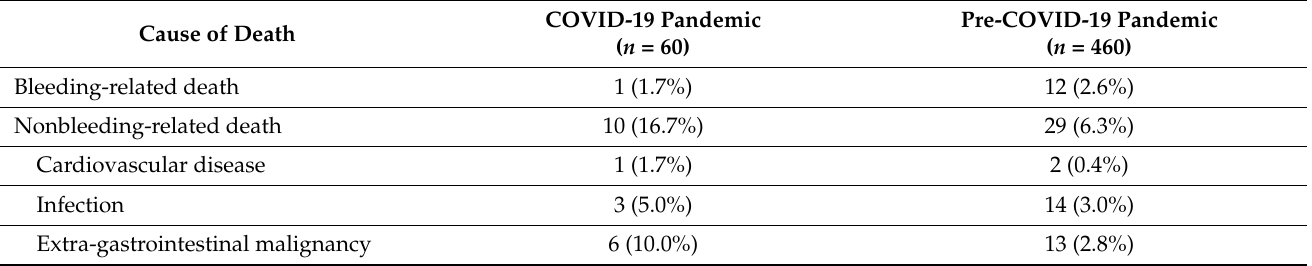
Table 3. Causes of death among the overall population before and during the COVID-19